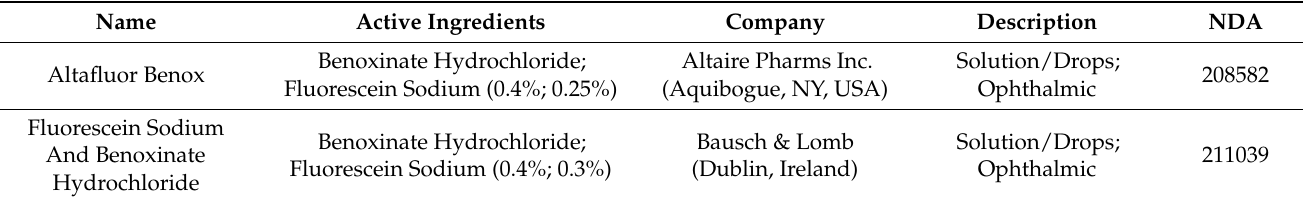
Table 4. FDA-approved products with